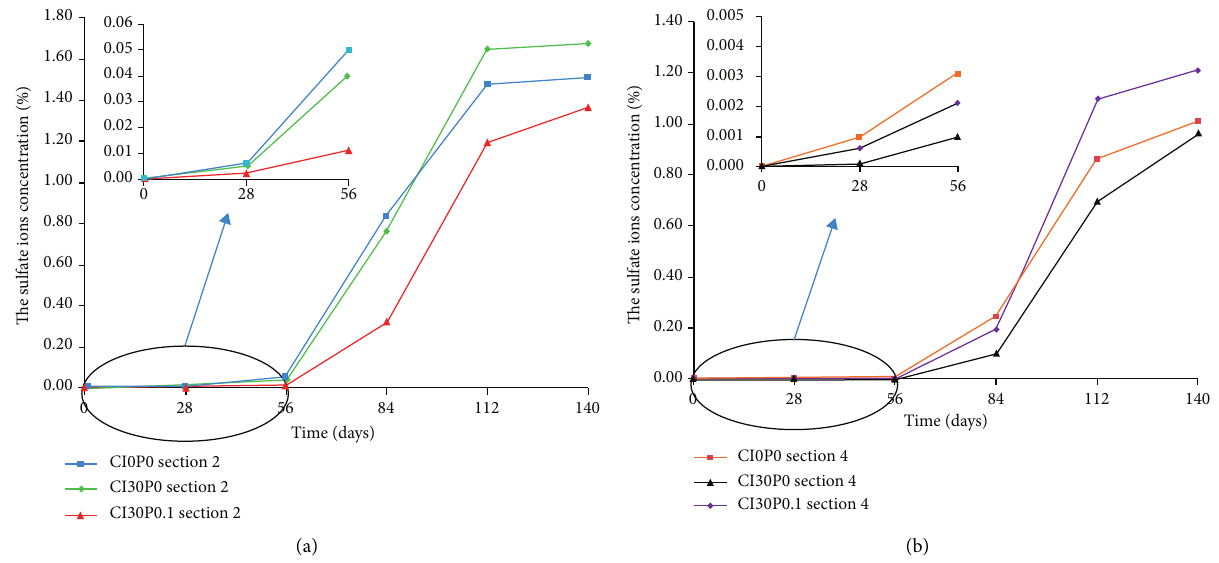
Figure 14: The distribution of sulfate ions. (a) Section 2. (b) Section 4.